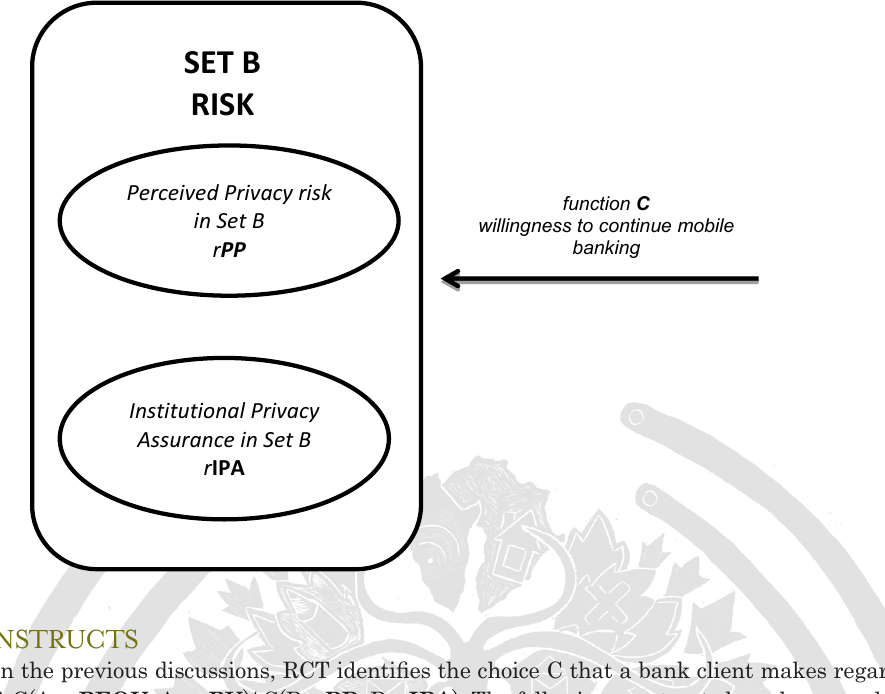
function C willingness to continue mobile